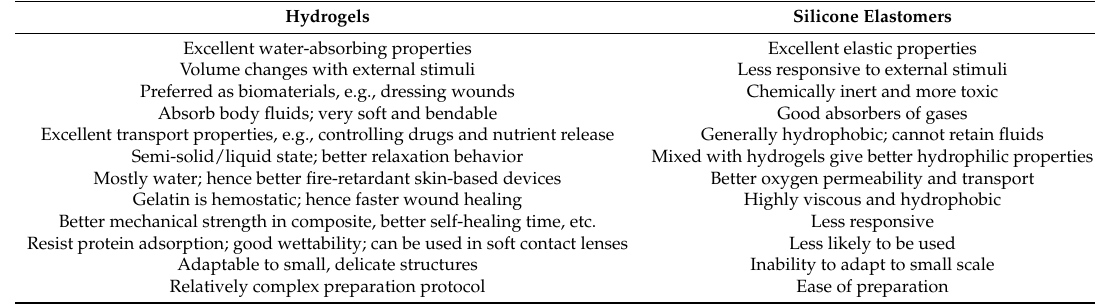
Table 1. Some selected key comparisons between hydrogel and silicone elastomer